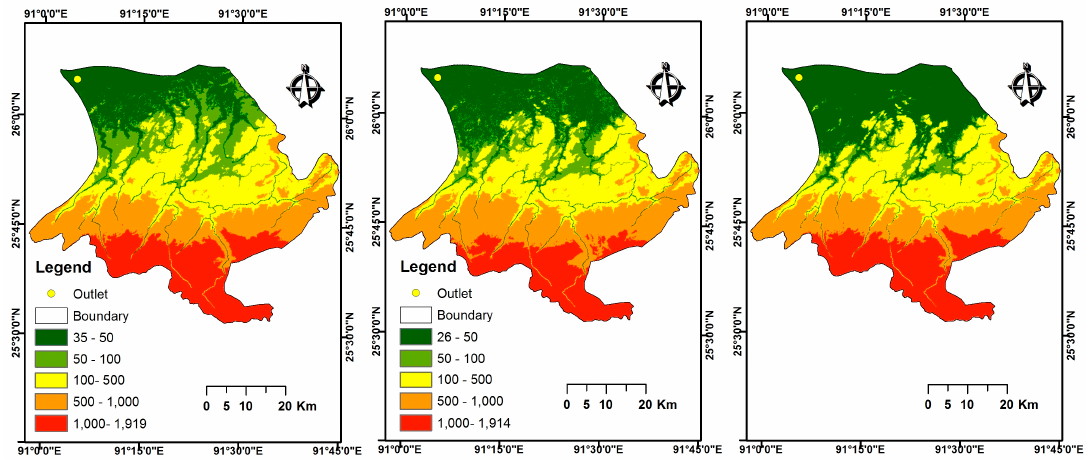
Figure 3. Depressionless Digital Elevation Models (DEM) used in the study.